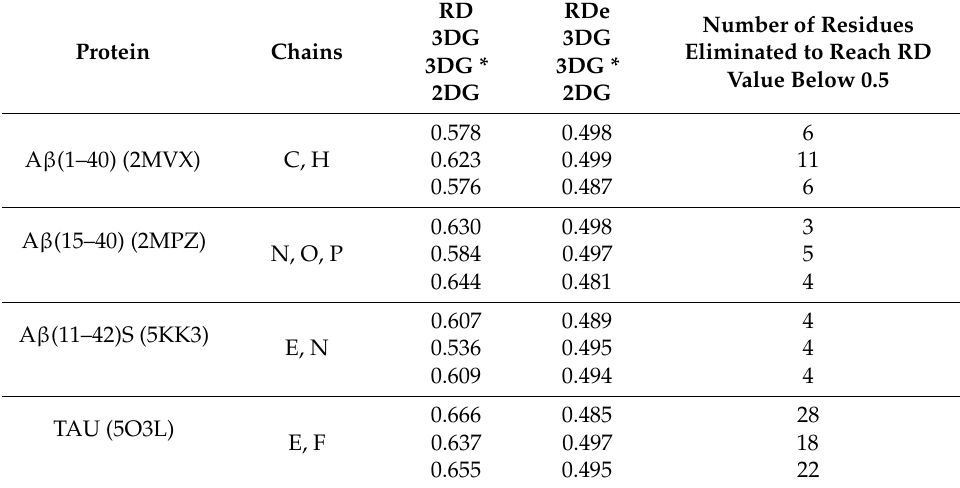
Table 3. Status of a set of chains forming a common "floor" within a superfibril expressed by means of a 3D Gaussian (3DG) distribution: a set of chains treated as an individual structural unit; 3D Gauss* (3DG*): determined for a set of chains treated as a superfibril component; 2D Gauss (2DG): a set of chains treated as an individual structural unit. RDe: RD values obtained after elimination of number of residues listed in the right column. The residues that are di ff erent for the set of eliminated residues are